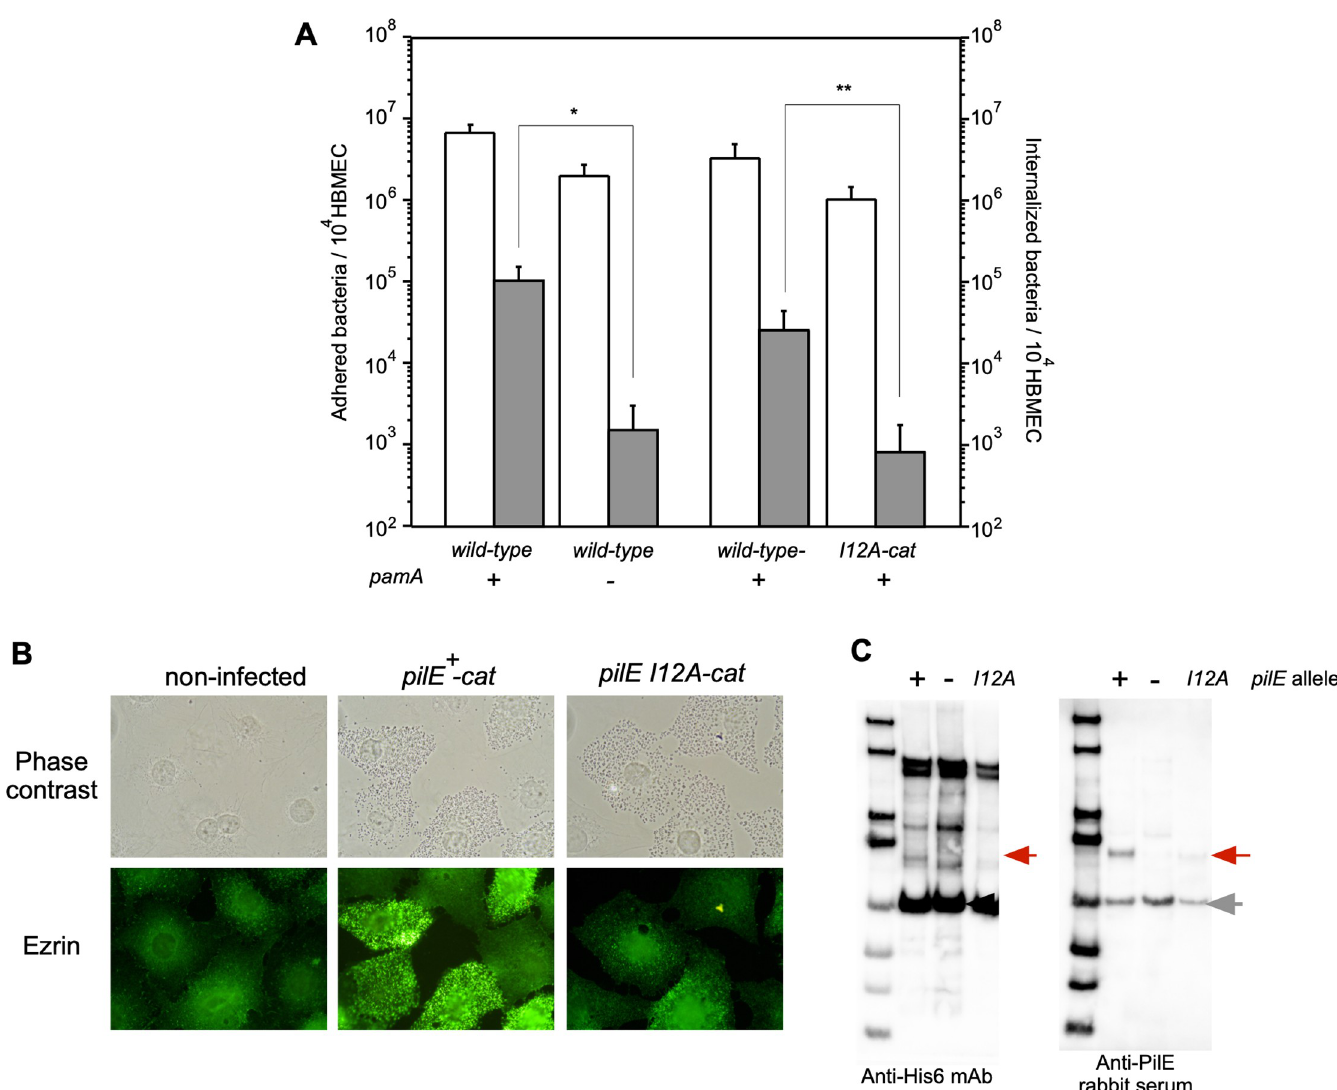
Fig 6. The pilE I12A N . meningitidis mutant also showed reduced internalization into HBMEC, the induction of cytoskeleton rearrangements, and interactions with PamA in N . meningitidis . (A) A I12A mutation in the pilE gene affects N . meningitidis internalization into HBMEC. Adherence (white) and internalization (gray) of N . meningitidis strains in HBMEC. Each value is the mean ± standard error of the mean (CFU per 10 4 HBMEC) from at least four experiments. The bars indicate the bacterial numbers of N . meningitidis wild-type pamA + (HT1125, left), Δ pamA :: spc (HT1822, middle-left), pilE + -cat (HT1744 middle-right), and pilE I12A-cat (HT2167, right), respectively (see S1 Table). � P < 0.01, �� P < 0.02, significantly different from the pamA + strain or pilE + -cat strain. (B) Immunofluorescence microscopy showing the accumulation of ezrin beneath N . meningitidis strains. The HBMEC monolayer was infected with wild-type pilE + -cat (middle) and pilE I12A-cat (right) N . meningitidis strains. A non-infected HBMEC monolayer is also shown in the left panels. Bacteria and HBMEC were observed by phase-contrast microscopy (upper panels). Ezrin was immunostained with anti-ezrin mAb and Alexa Fluor 488-conjugated rabbit anti-mouse IgG (green channel, lower panels). (C) PilE I12A was crosslinked to PamA K278( p BPa) less efficiently than wild-type PilE in N . meningitidis . Black and red arrows show the crosslinked complex between PamA K278( p BPa) and PilE, and the gray arrow indicates an unidentified band that crossreacted with anti-PilE rabbit serum. +/- indicates the presence or absence of the pilE gene,